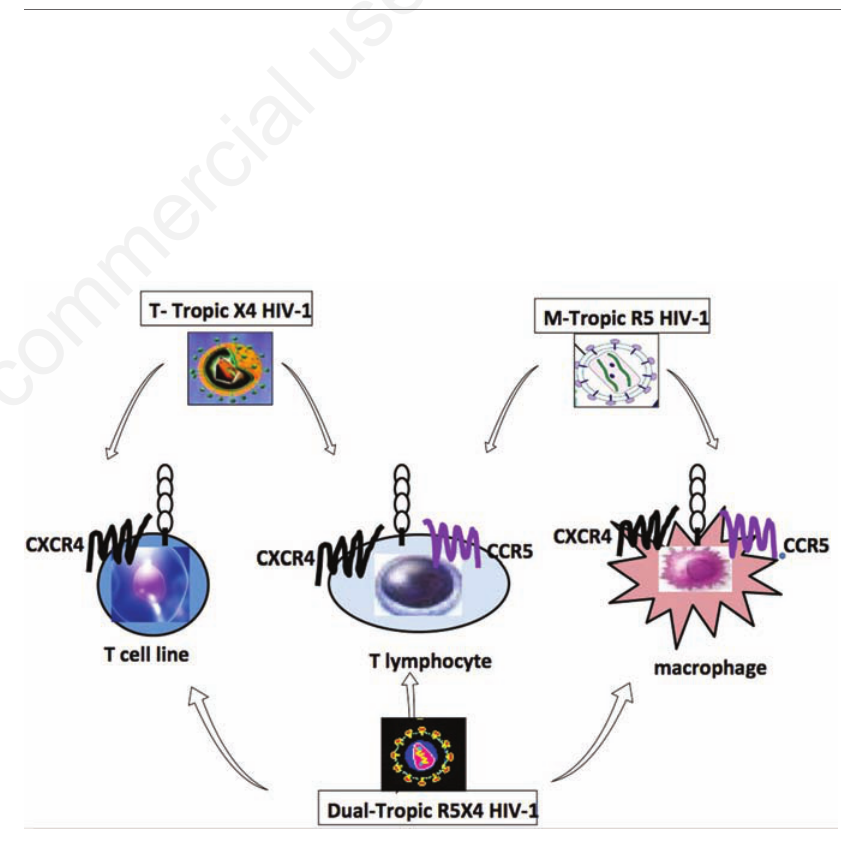
Figure 2. Coreceptor usage determines viral entry into different cell types and uncovered the mystery of cellular tropism. Macrophages and primary T lymphocytes express CCR5 and CXCR4 where T cell lines express only CXCR4. Macrophage (M)-tropic HIV-1 strains infect macrophages and lymphocyte using CCR5, while T-cell line (T)-tropic strains infect lymphocytes and T cell lines (but not macrophages) by using CXCR4. All three cell types are infectable by the dual-tropic strains by using either coreceptors for entry. T lymphocytes are infectable by all strains of